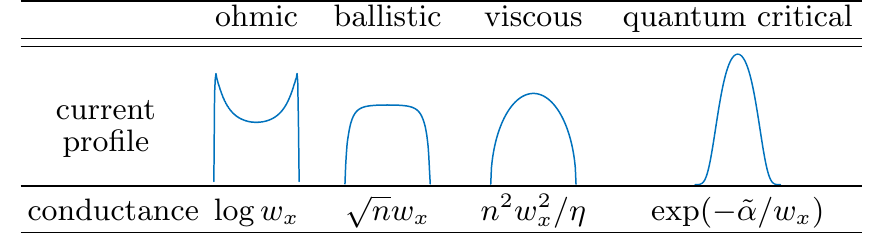
Table 1: Summary of how to distinguish between different qualitative flow regimes.